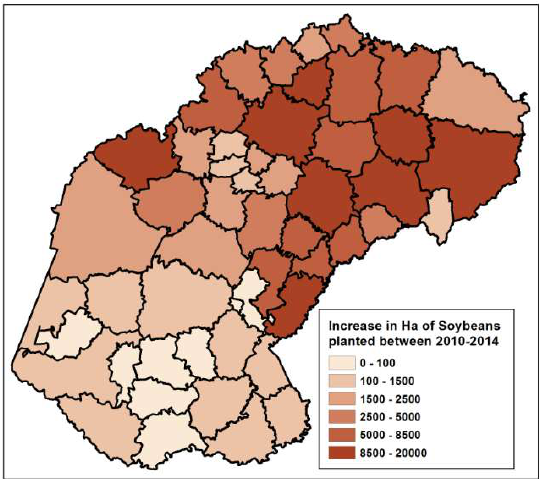
Figure 11. Calculated increase in area (Ha) of soybeans cultivated in 2010 and 2014 Following the process above, the increase and decrease per crop per district between years could be expressed in area hectares. The results of increase or decrease of maize in the Freestate between 2014-2015 and between 2015-2016 are displayed as Figure 9. Calculated percentage of soybeans from other maps in Figures cultivated crops in 2010